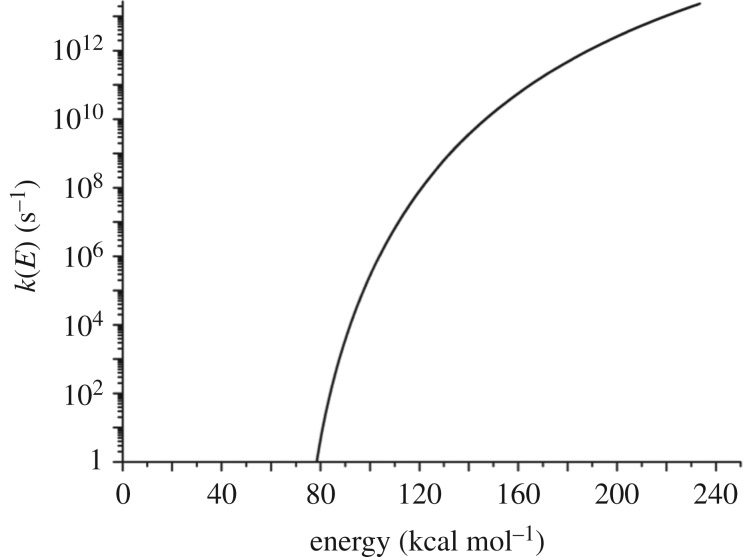
Value of k(E) for SCH3 dissociation to S + CH3 at the diamond surface, calculated via ILT as described in the text.